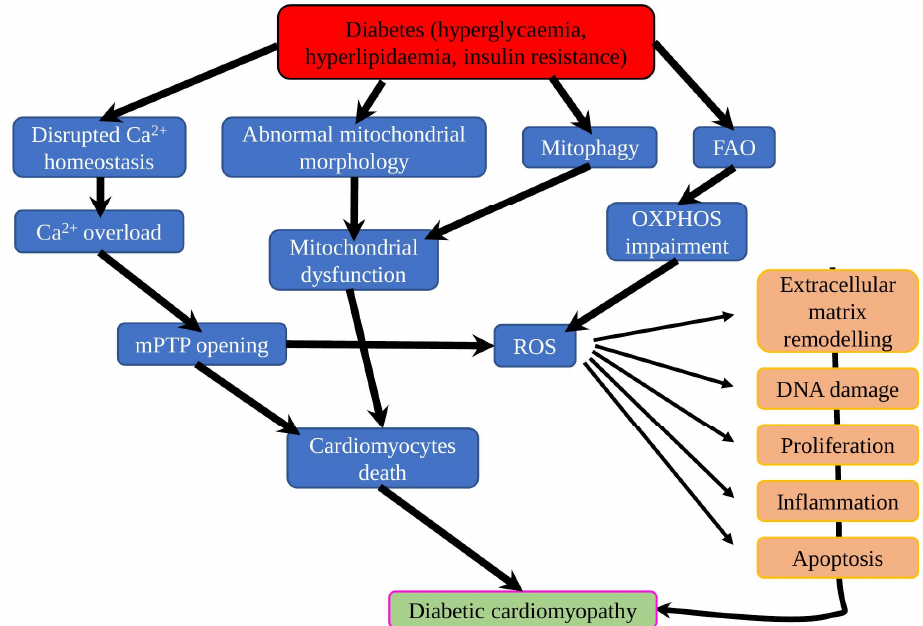
Figure 3. Involvement of mitochondrial dysfunction in diabetic cardiomyopathy. In the diabetic condition, ATP is mostly generated from FAO instead of glucose, which leads to OXPHOS impairment and generates more ROS. Disrupted Ca 2+ handling leads to mitochondrial Ca 2+ overload and mPTP opening, which causes mitochondrial respiratory dysfunction, increased ROS production and a number of consequential effects (such as increased DNA damage, apoptosis rate, inflammation and others). Mitophagy plays a protective role, removing damaged mitochondria and attenuating mitochondrial dysfunction.